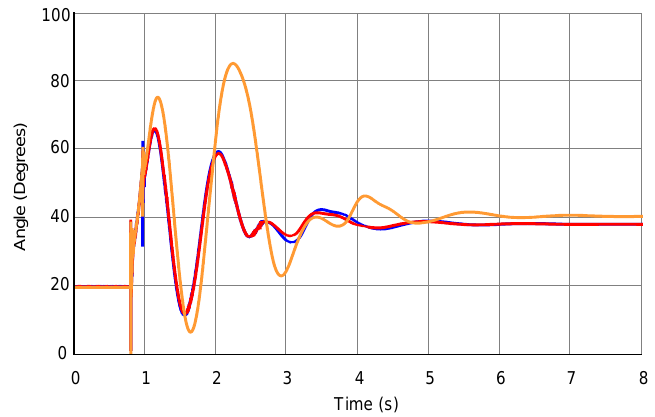
Figure 11. Machine A angle response of the over-SIL test system against a 10-cycle fault: without SVC PMACH1 vs. ang6-1f (yellow), RTDS-based WAC-SVC (red), and delay-compensated HIL-based WAC-SVC